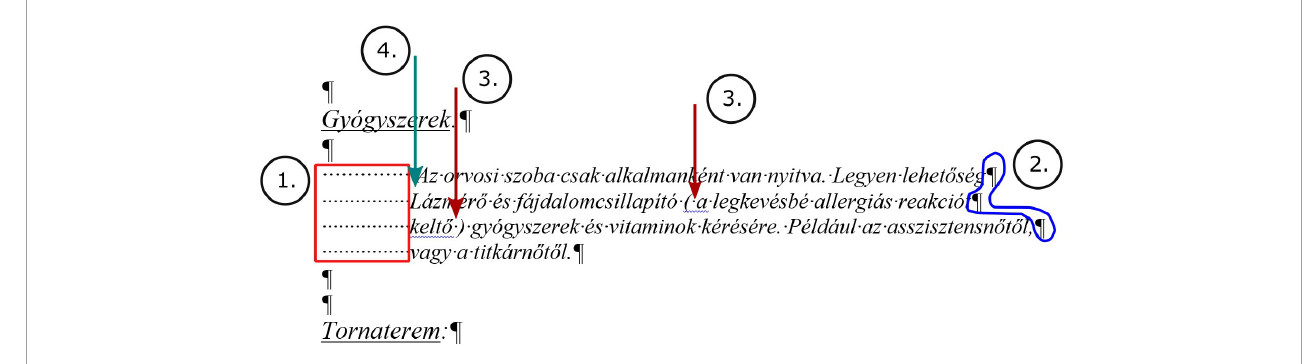
FIGURE2 The layout errors of the selected